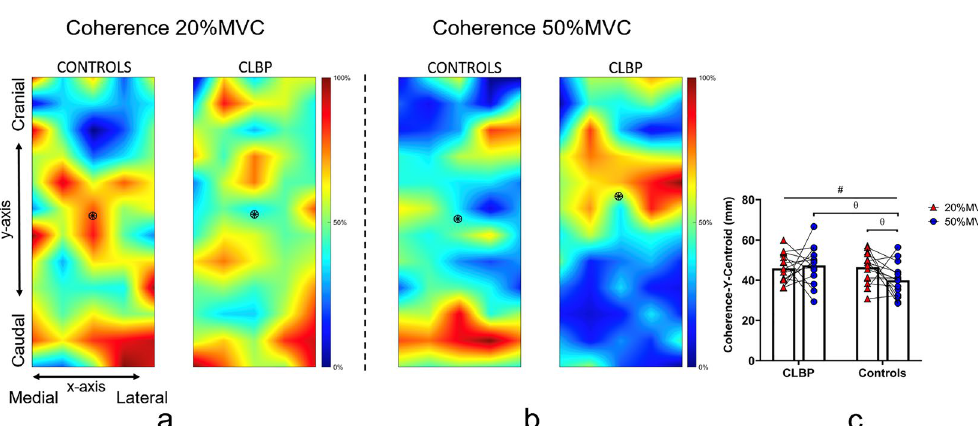
Figure 5. Topographical maps of averaged normalized (to the maximum coherence value) coherence across participants at ( a ) 20% and at ( b ) 50%MVC. The black circle in the topographical maps ( a , b ) represents the centroid of coherence, which was calculated from the bottom of the electrode grid. The spine is located towards the medial side of the x-axis. Figure ( c ) depicts the position of the y-axis centroid for both groups at 20% and 50%MVC (#interaction effect: group*torque, θ: post hoc tests). Hotter/red colors represent higher coherence, while blue/cold colors represent lower